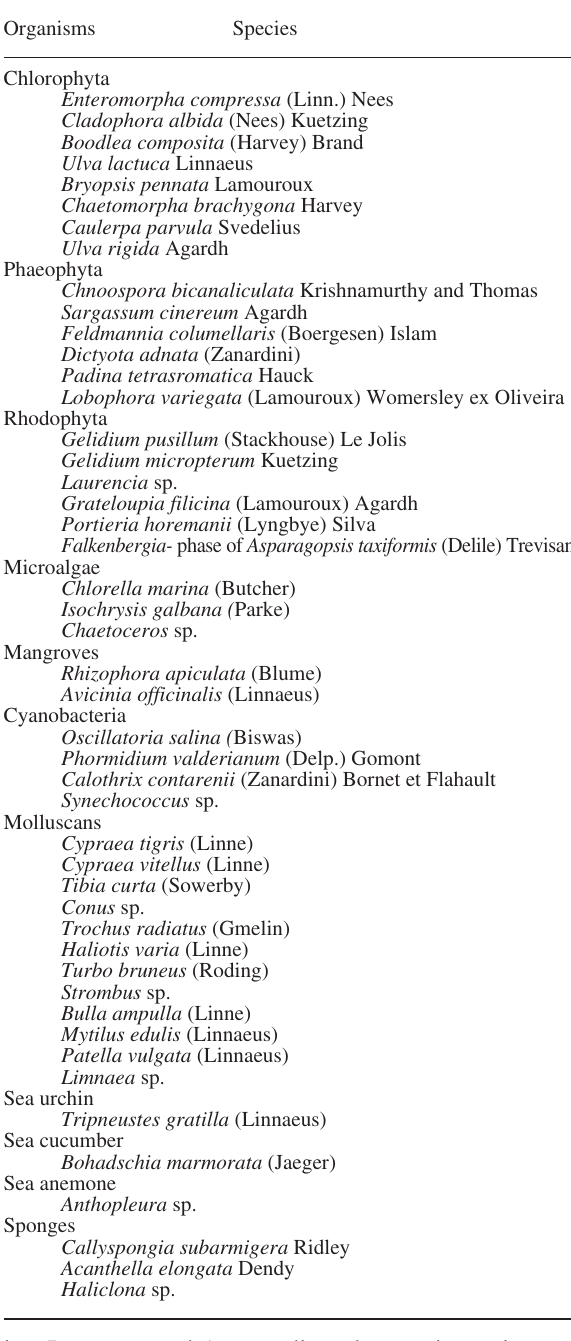
Table 1. – List of marine organisms collected from the Kollam coast.